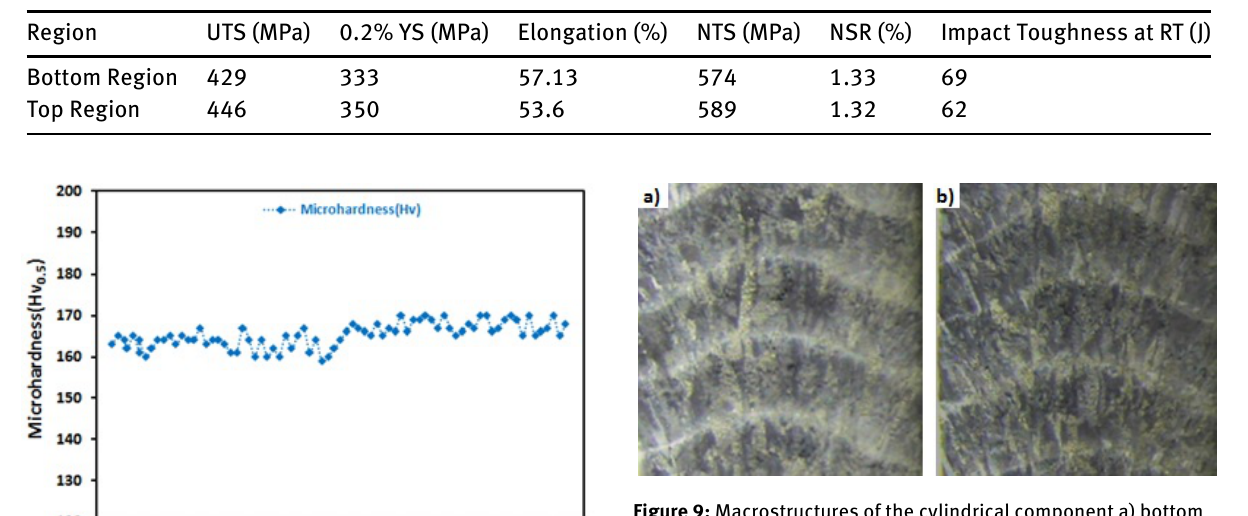
Figure 9: Macrostructures of the cylindrical component a) bottom region and b) top